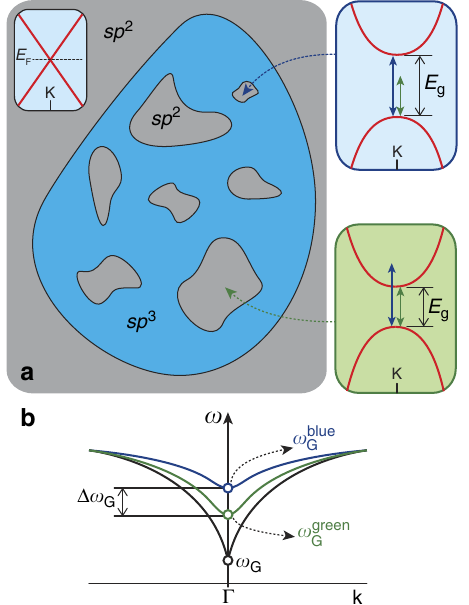
Fig. 3 Mechanism for the G band dispersion with excitation laser energy. a Illustration of an sp 3 matrix ( blue region ) inserted in a graphitic ( sp 2 ) system ( gray region ). The inset at the left side shows the linear energy dispersion of π electrons at the corner (K point) of the fi rst Brillouin zone of pristine graphene. E F stands for the Fermi level, which occurs at the K point for undoped graphene. The quantum con fi nement of π electrons inside small sp 2 sites opens up band gaps of magnitude E g at the K point. The smaller/larger ‘ 2 is, the wider/narrower the associated band gap becomes sp (larger/smaller E g ), as illustrated in the top/bottom insets at the right side. The lengths of the green and blue arrows in these insets represent the photon energies of the blue ( E L = 2.54 eV) and green ( E L = 2.33 eV) excitation laser sources, respectively. An eventual match between E L and E g enhances the Raman scattered signal, and therefore smaller/larger sp 2 sites favor the Raman signal obtained with the blue/green laser source. b Double-degenerated TO/LO phonon dispersion near the center of the fi rst Brillouin zone ( Γ point). The black line is related to the unperturbed graphene lattice. The ω G is the value of the TO/LO branches at Γ , and the kink in the TO/LO dispersion is a Kohn anomaly. The presence of the band gap in the π electron dispersion near the K point weakens the screening effect that gives rise to the Kohn anomaly, which attenuates the softening in ω G . Since the band gap becomes wider as the sp 2 sites become smaller, the G band measured using the blue laser presents a higher frequency value > ω green than the G band frequency measured with the green laser, that is, ω blue G